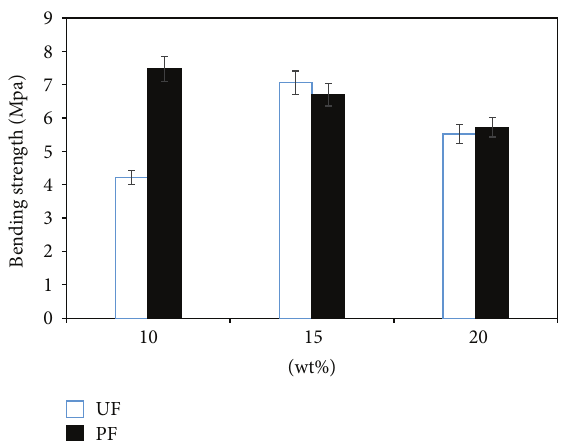
Figure3:Young’sModulusofsagoparticleboardversusresinmatrix content